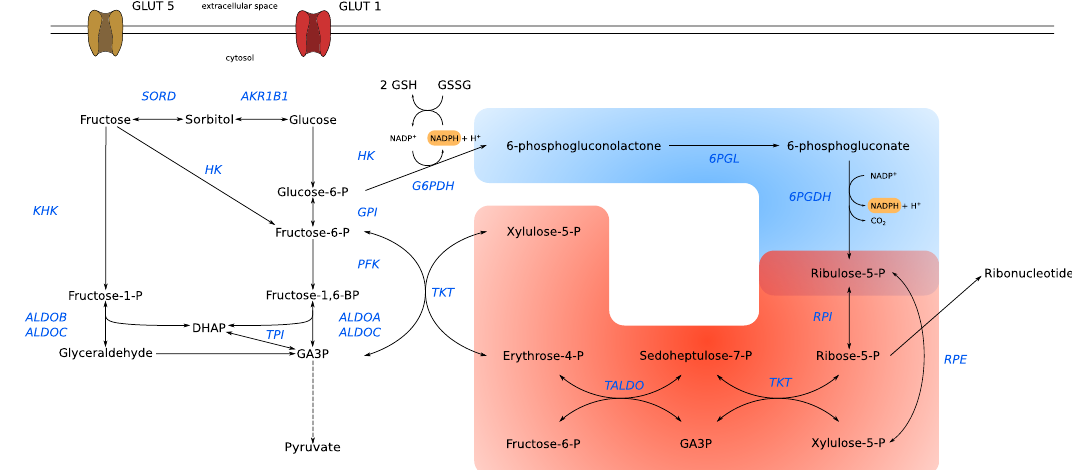
Figure 2. Fructose contribution to the pentose phosphate pathway. Fructose can contribute to the oxidative (blue) as well as the non-oxidative (red) pentose phosphate pathway (PPP). To enter the oxidative PPP, fructose has to be either metabolized via the polyol pathway to glucose and further to G6P or directly via HK to F6P which can be converted to G6P. Direct phosphorylation via HK to F6P provides also a substrate for the non-oxidative PPP. Together with GA3P, F6P is converted by TKT to X5P and E4P. GA3P can also be provided by fructose metabolized via KHK. Both F6P and GA3P are used in further reactions of the non-oxidative PPP, demonstrating multiple entry points of fructose into the non-oxidative PPP. AKR1B1: aldo-keto reductase family 1, member